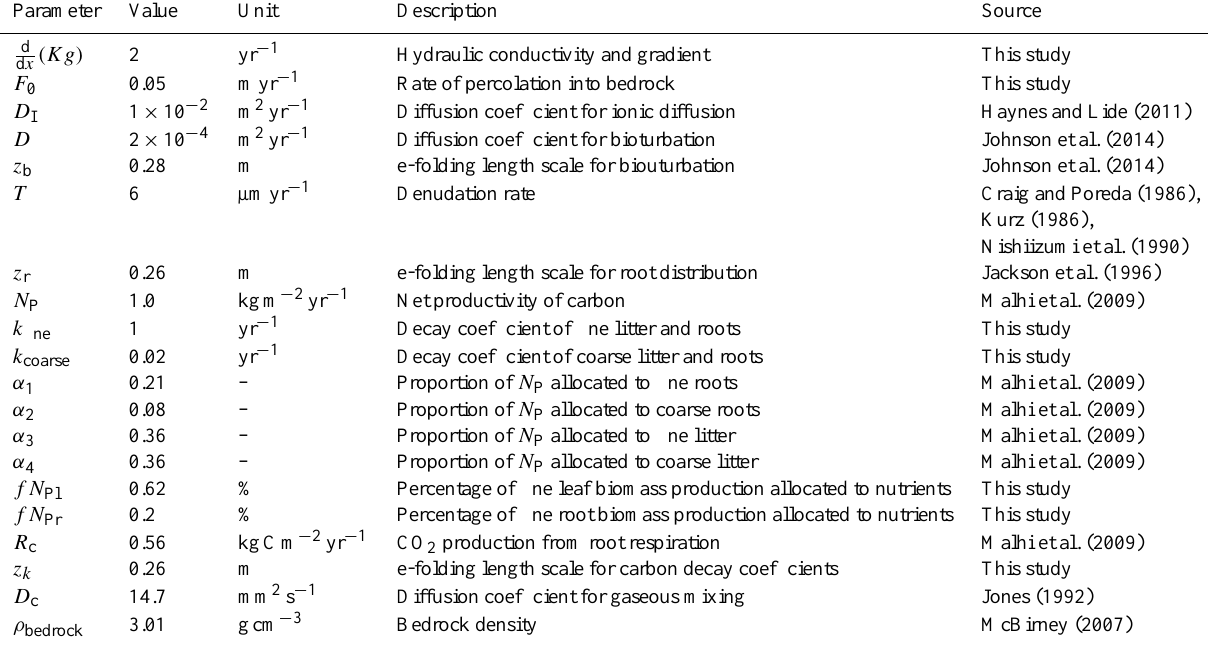
Table 1. Model parameters. Parameter